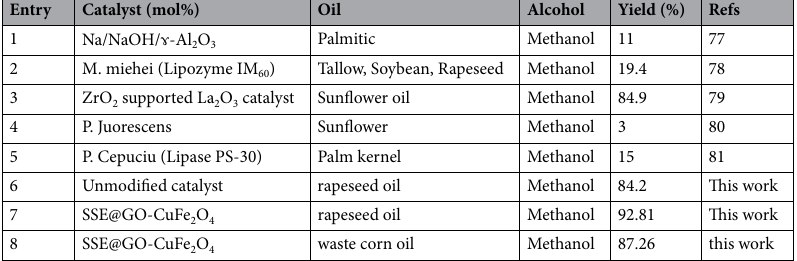
Table 5. A comparison of catalytic performance for the transesterification